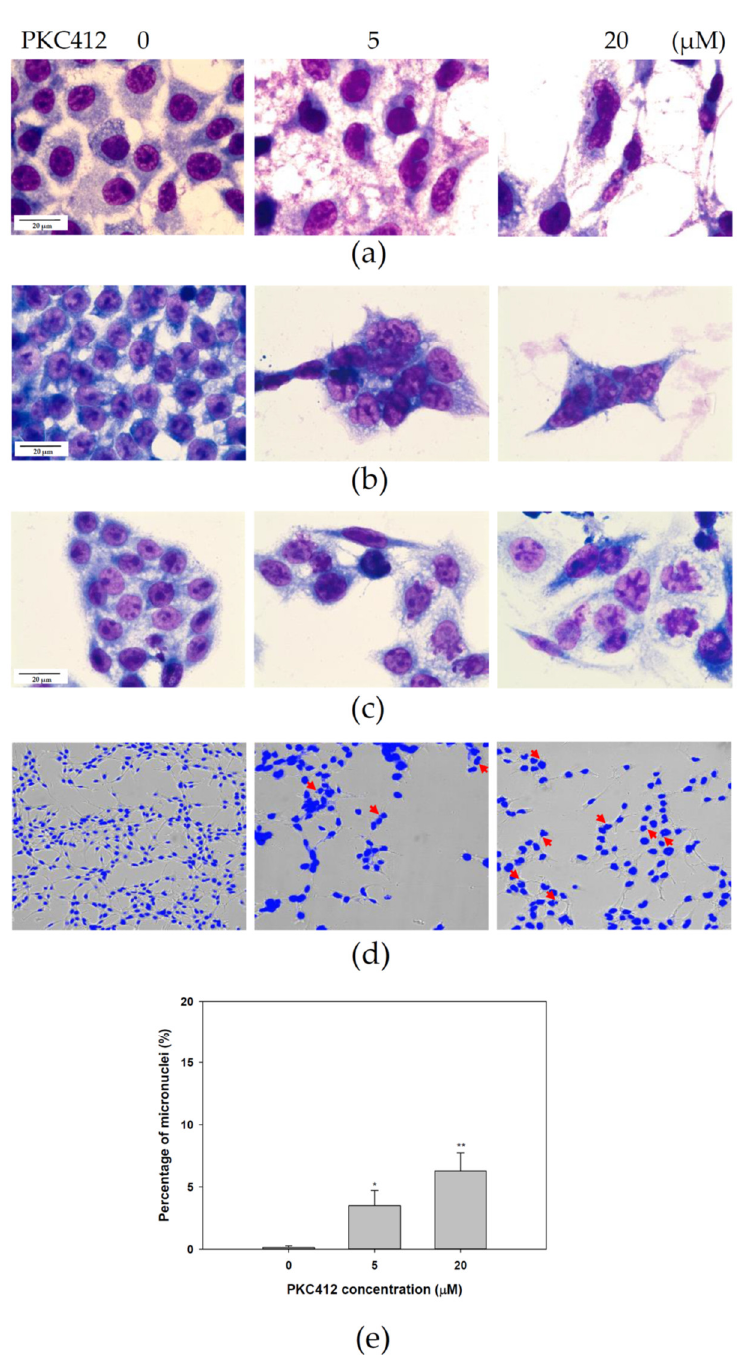
Figure 3. Morphology examination of colorectal carcinoma cells treated with midostaurin (PKC412). After treatment, morphologies were stained with Liu’s stain and photographed under light microscopy in 1000-fold magnification. The representative morphology of CT26 ( a ), HCT116 ( b ), and SW480 ( c ) cells was shown after staining. For micronucleic detection, CT26 cells were washed with PBS and fixed in 4% paraformaldehyde. The slides were subsequently stained with 1 μg/mL of DAPI for 10 min. The morphology and fluorescence expression were visualized and photographed under ImageXpress ® Micro 4 microscope in 200-fold magnification ( d ). Arrow (red) indicates the micronucleic formation. The proportion of micronucleic induced by PKC412 was counted ( e ). Data from three separate experiments were expressed as mean ± SEM. Significant differences between control cells and cells treated with PKC412 are indicated by * p < 0.05 and ** p < 0.01.